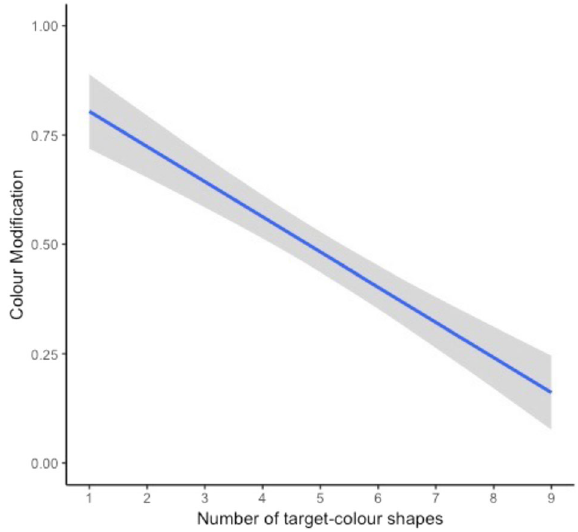
Fig. 8 Regression line showing the main effect of Condition (number of target-color shapes) on the production of redundant color adjectives. The shaded band around the regression line represents a 95% con fi dence region for the regression fi